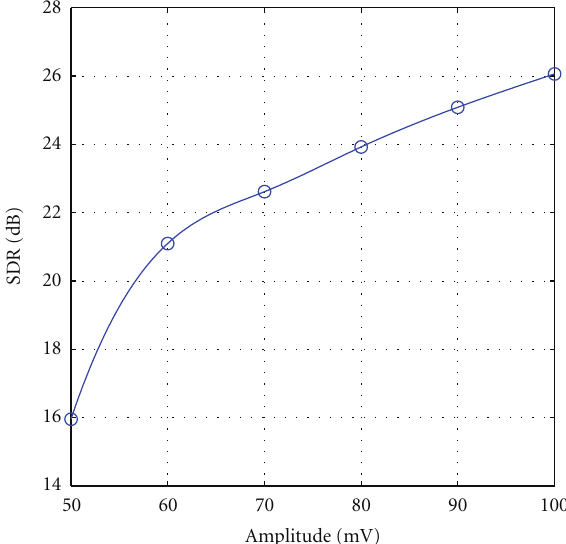
Figure 2: SDR as a function of the signal